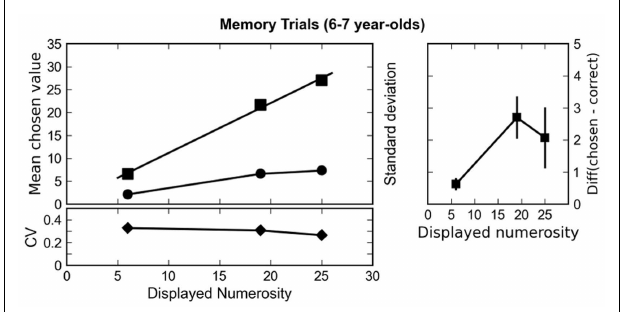
FIGURE 2 | Left column: mean responses (chosen values, squares) of the subjects and standard deviations (circles) plotted against the correct outcome for memory trials .The lower part depicts the coefficient of variation (CV, diamonds) – that is, the ratio of standard deviation and mean chosen value, plotted against the displayed numerosity. A constant coefficient of variation indicates that variability of chosen values increased proportionally with mean chosen value. In turn, this can be understood as an instantiation ofWeber’s law. Right column: the difference between the displayed numerosity and the chosen value plotted against the displayed numerosity. Positive values indicate that children tended to overestimate the remembered numerosities. Error bars indicate the standard error of the